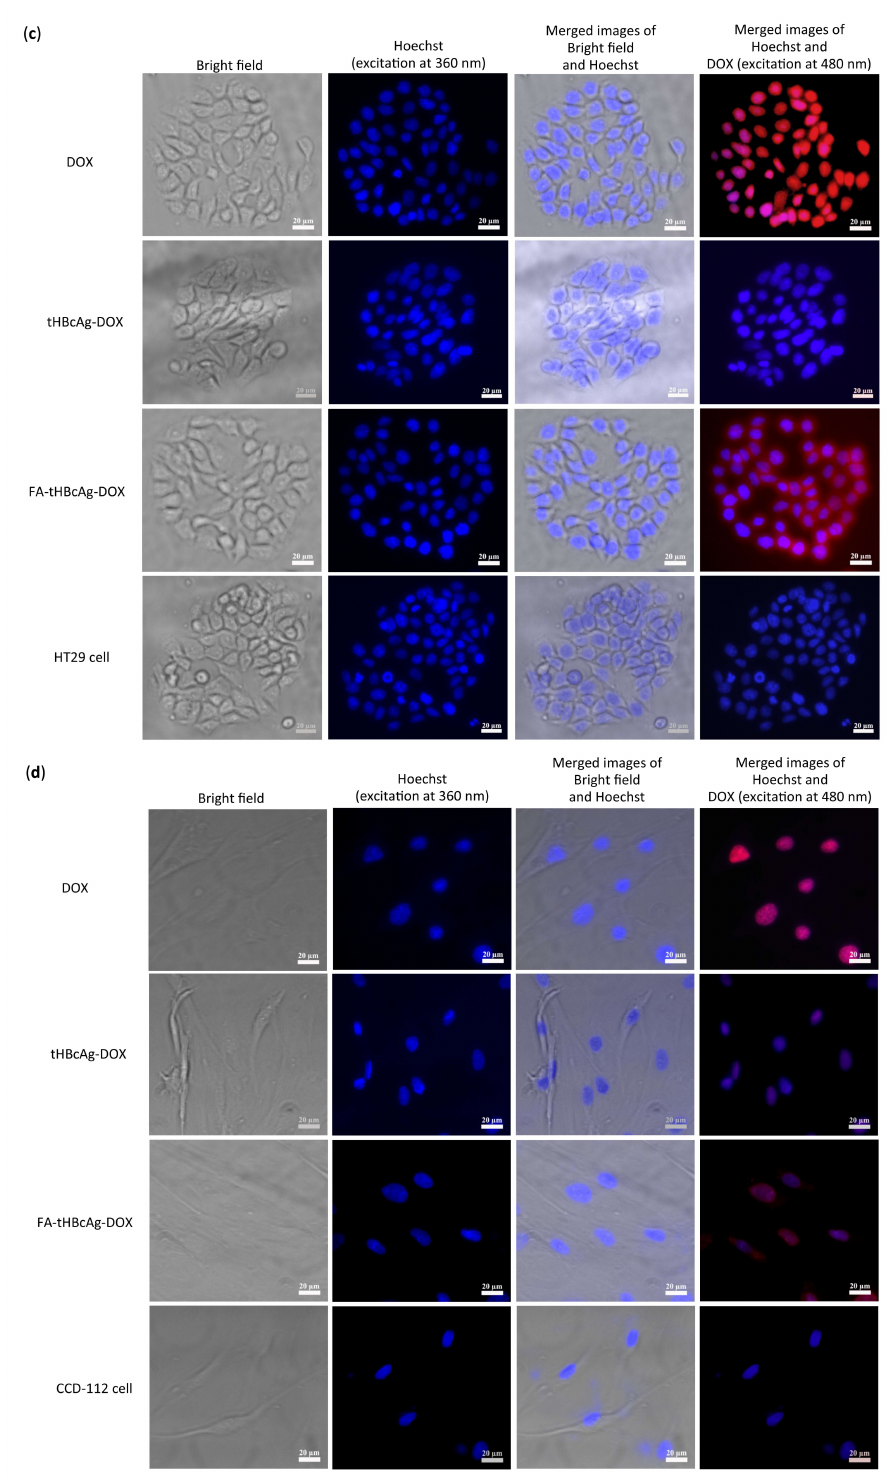
Figure 8. Delivery of doxorubicin by dual conjugated tHBcAg VLNPs into cancer (HeLa, HT29) and normal (3T3, CCD-112) cells. ( a ) Human cervical cancer HeLa; ( b ) normal 3T3; ( c ) human colorectal cancer HT29; and ( d ) normal CCD-112 cells were treated with equivalent DOX concentration (5 µ g/mL) of doxorubicin (DOX) alone, DOX-conjugated tHBcAg VLNPs (tHBcAg-DOX), and tHBcAg VLNPs conjugated with folic acid (FA) and DOX (FA-tHBcAg-DOX) for 1 h. The cells without treatment served as negative controls. DOX was detected at 480 nm. Scale bars indicate 20 µ